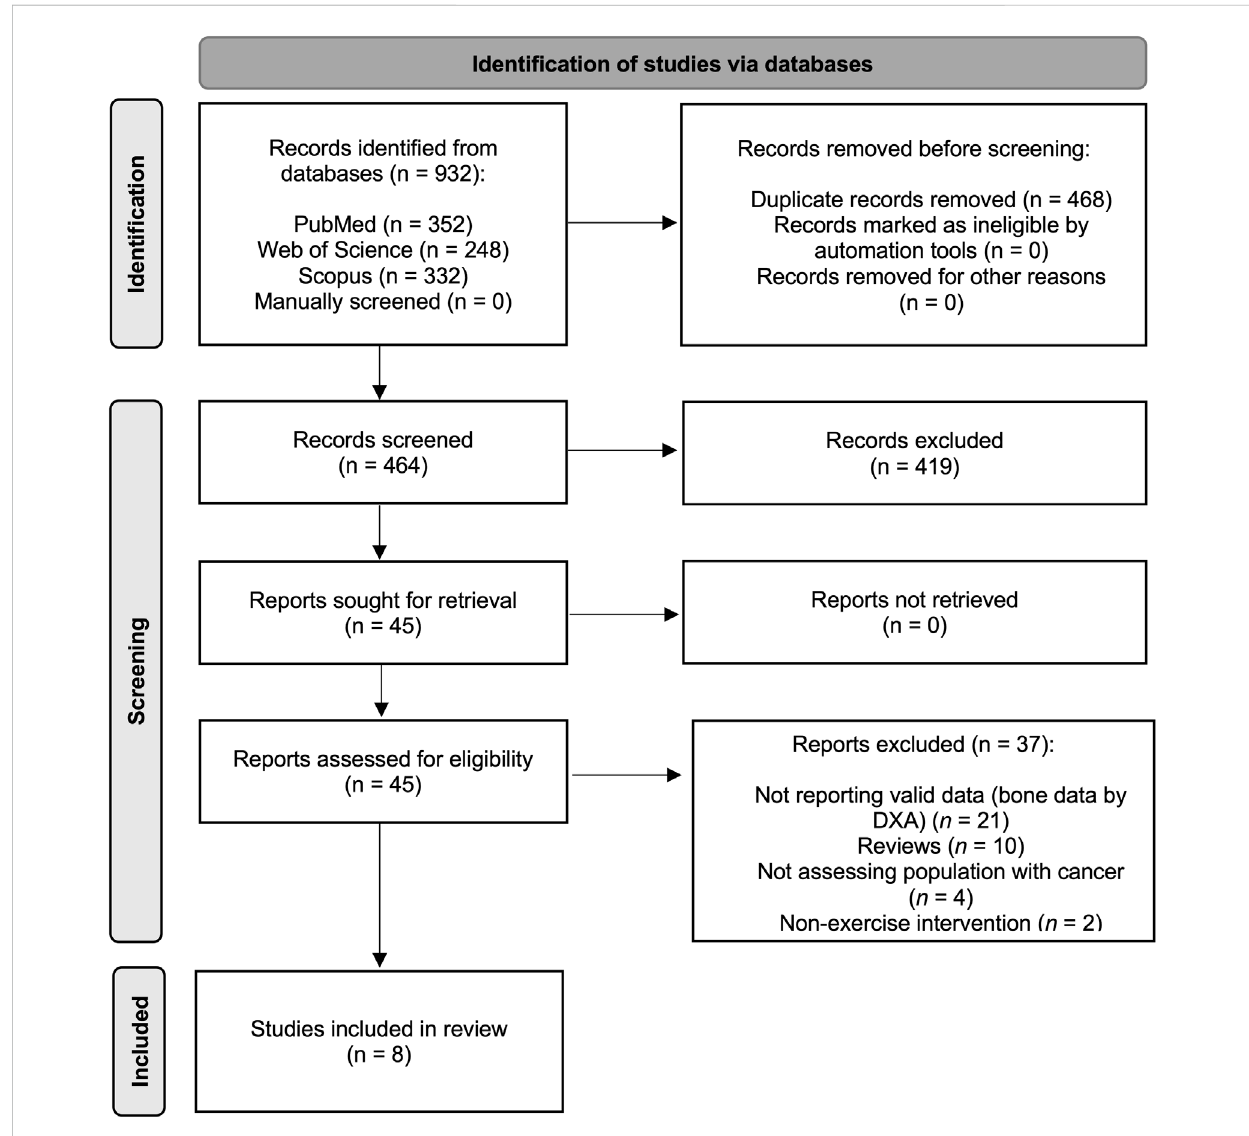
FIGURE 1 Literature search Preferred Reporting Items for Systematic Reviews and Meta-Analyses (PRISMA) consort